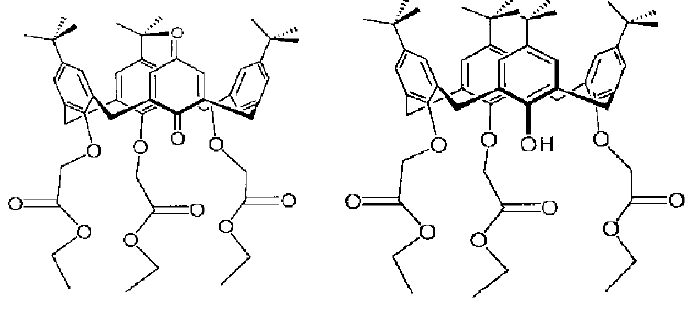
Figure 16. Triester of calix[4]arene and